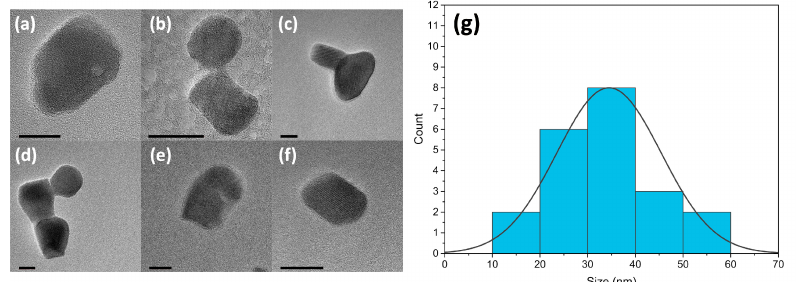
Figure 3. ( a – f ) A set of TEM images of Er 3 + :YAG nanoparticles, scale bar in all images is 20 nm. ( g ) Histogram showing particle size distribution profile and average size of the